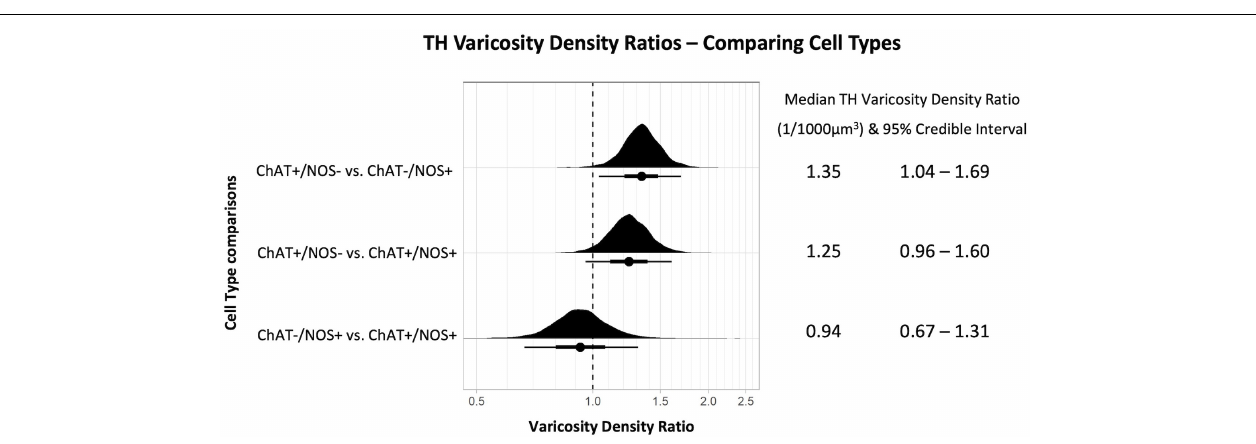
FIGURE 4 | Graph of tyrosine hydroxylase varicosity density ratios comparing cell types. Density ratio is plotted on a logarithmic scale. The filled black curves indicate the ratio between the distributions of the mean of density (mean varicosity density of cell type divided by another). The bars beneath indicate the median (dot), the 66th percentiles and the 95th percentiles of the mean. A ratio of 1.0 indicates that the densities for the two types of cells compared are identical. In this graph, ChAT +/NOS– cells compared to the ChAT–/NOS + cells have a median density ratio of 1.35 and the 95% percentile bar is to the right of 1.0. This shows there is a significantly greater varicosity density close to ChAT +/NOS– cells compared to ChAT–/NOS + cells. The median TH varicosity density ratios are presented with the 95% credible intervals on the right. ChAT, choline acetyltransferase; NOS, nitric oxide synthase; TH, tyrosine hydroxylase.